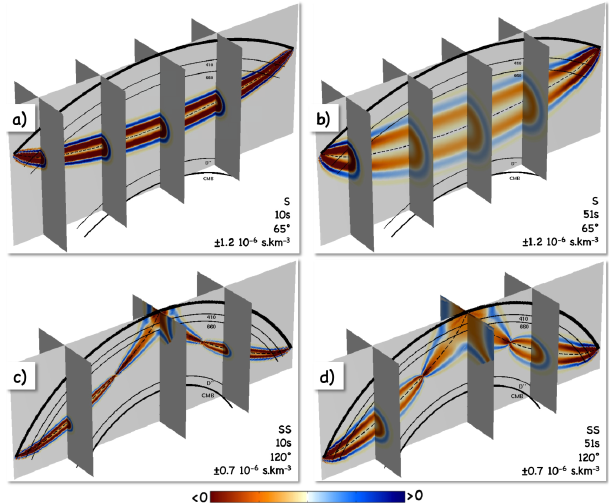
Fig. B1. Three-dimensional view of “analytical” ray-based finite- frequency delay-time sensitivity kernels. Each subfigure provides the phase name ( S or SS ), the dominant wave period (10 or 51s), the epicentral distance (65 ◦ for S , 120 ◦ for SS ), and the colour scale bounds (skm − 3 ). The source is at the surface, and the black dashed line represents the geometrical ray